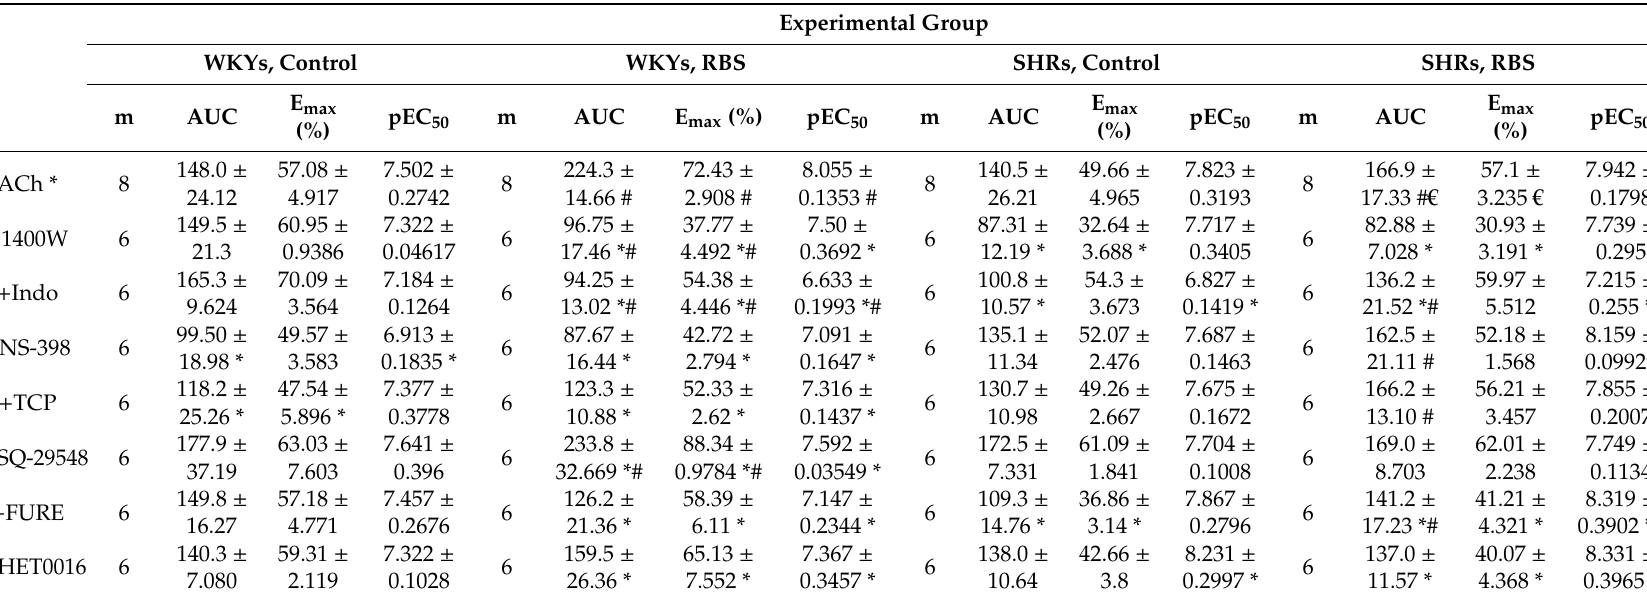
Table 2. Changes in the area under the curve (AUC), maximal responses (E max ), and pEC 50 (potency) of an intact thoracic aorta from rats fed with experimental diets for 6 weeks in response to